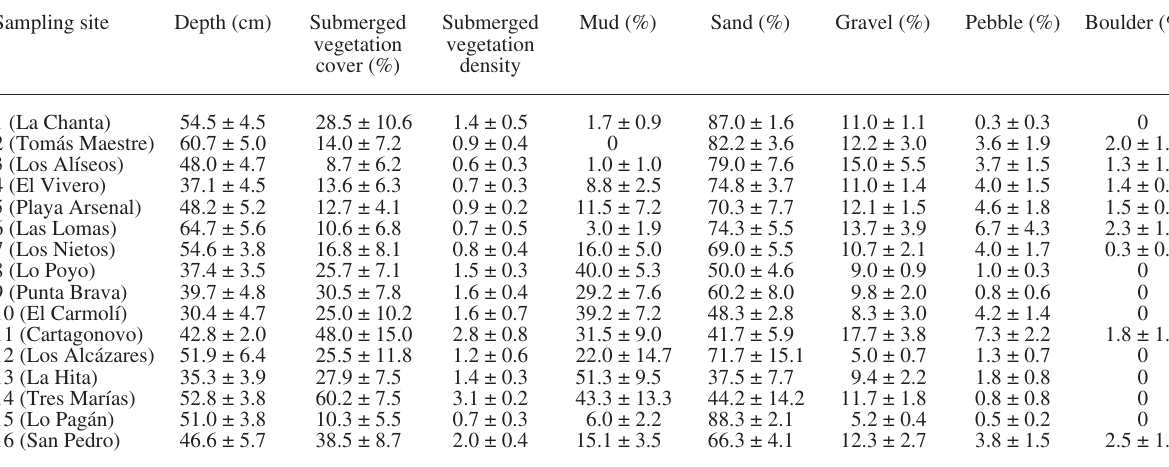
Menor coastal lagoon.